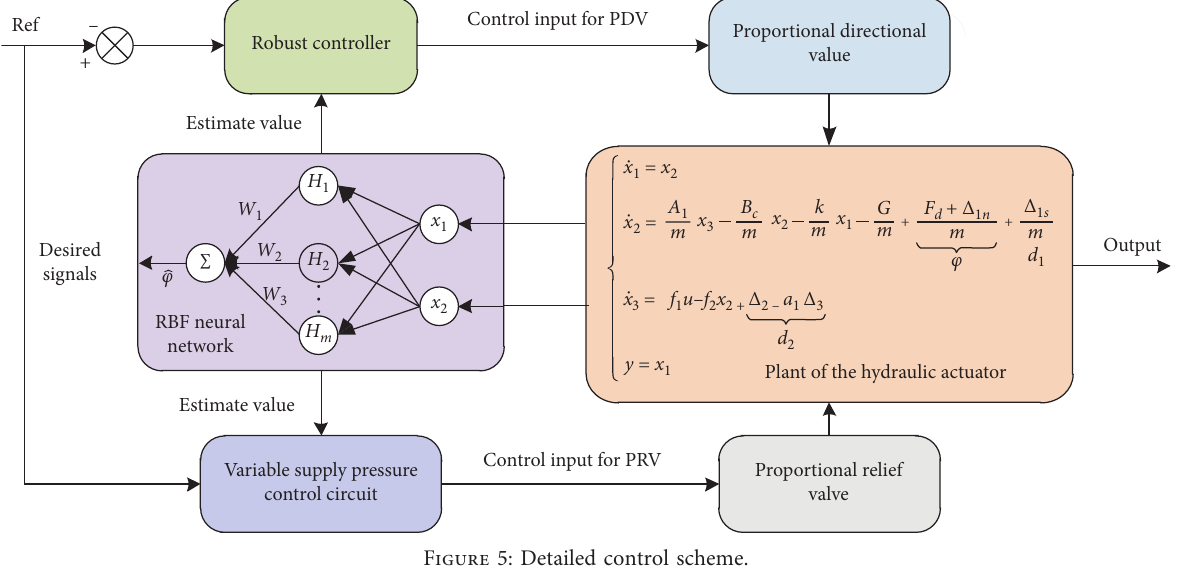
Figure 5: Detailed control